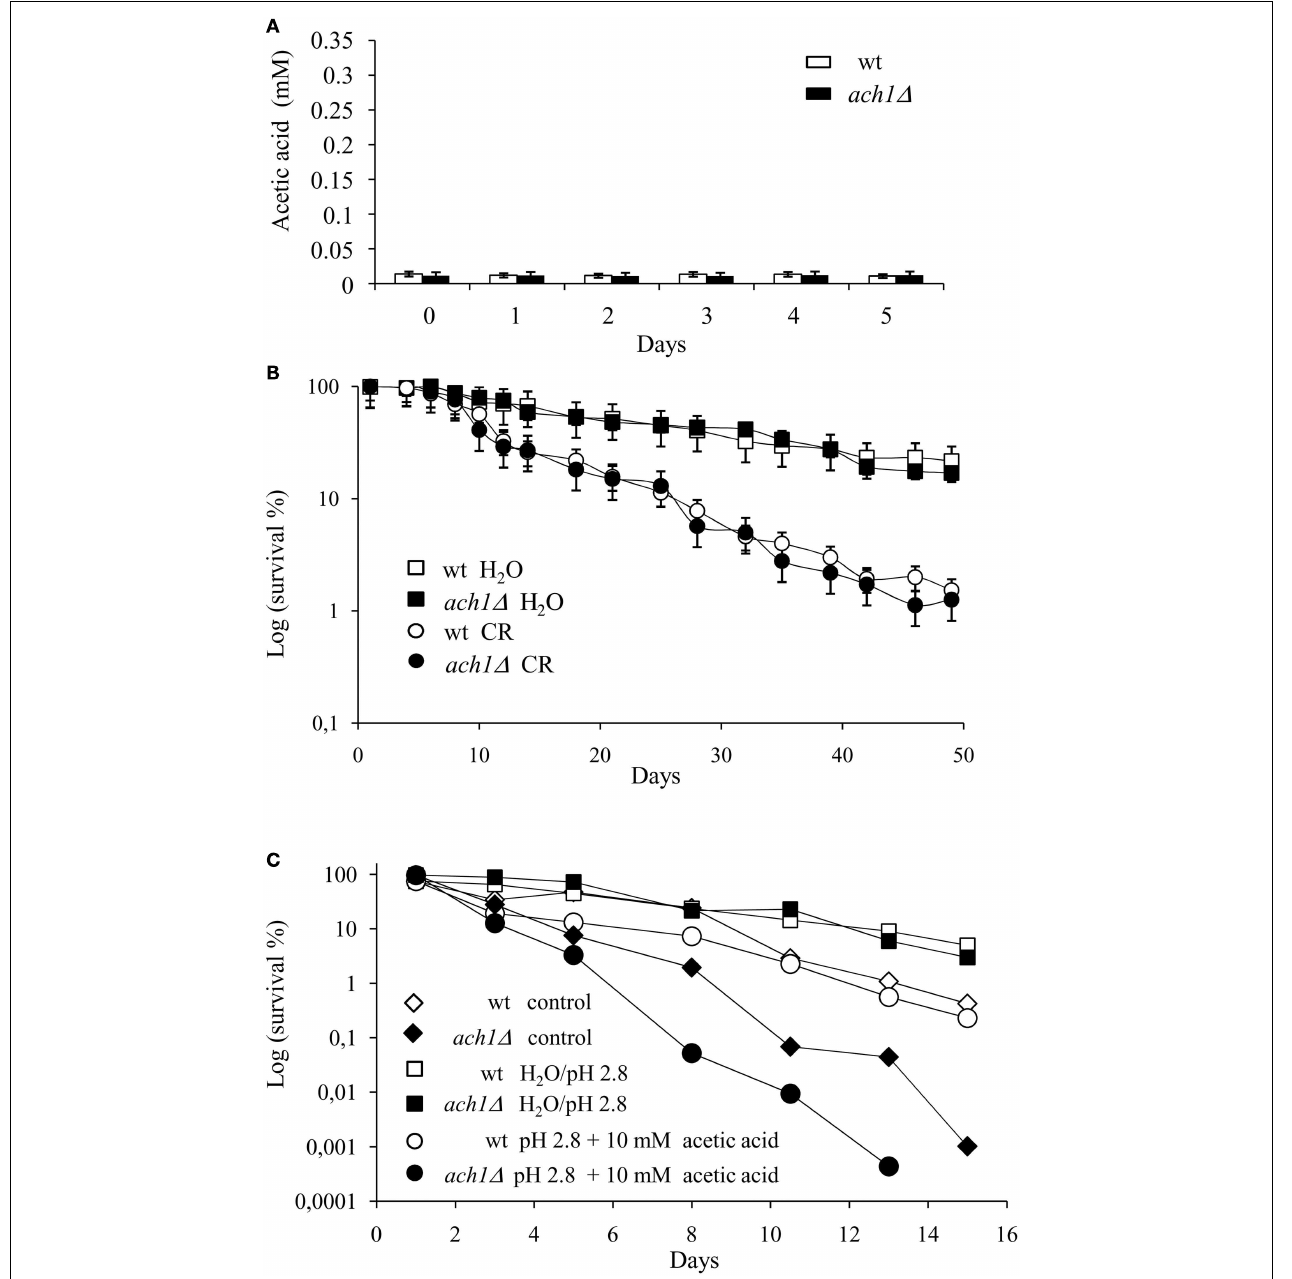
their exhausted medium was also monitored as control (reported in Figures 1C and 4C ). Error bars are the standard deviation of three replicates. ( C )Wild type and ach1 ∆ chronological aging cells grown on 2% glucose were switched to water adjusted to pH 2.8 and water/pH 2.8 containing 10mM acetic acid at Day 1. Every 48h, cultures were resuspended in fresh water/pH 2.8 and each time 10mM acetic acid was added. At every time-point, viability was measured as in (B). Survival of cells in their exhausted medium was also monitored (control). One representative experiment is